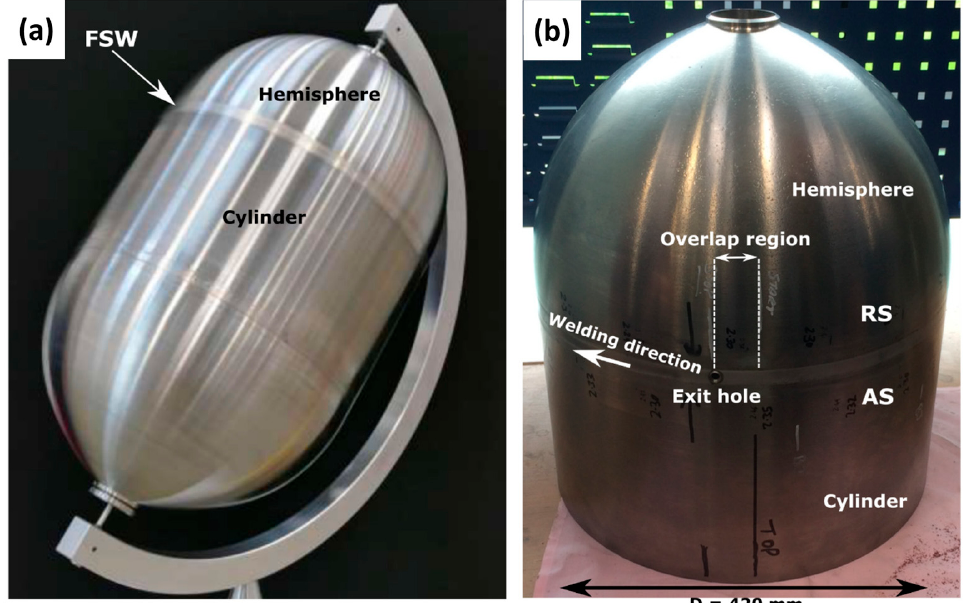
Figure 15. Images of ( a ) prototype of the propellant tank, ( b ) friction stir welded hemicylinder showing overlap region [42] (has permission from Elsevier).